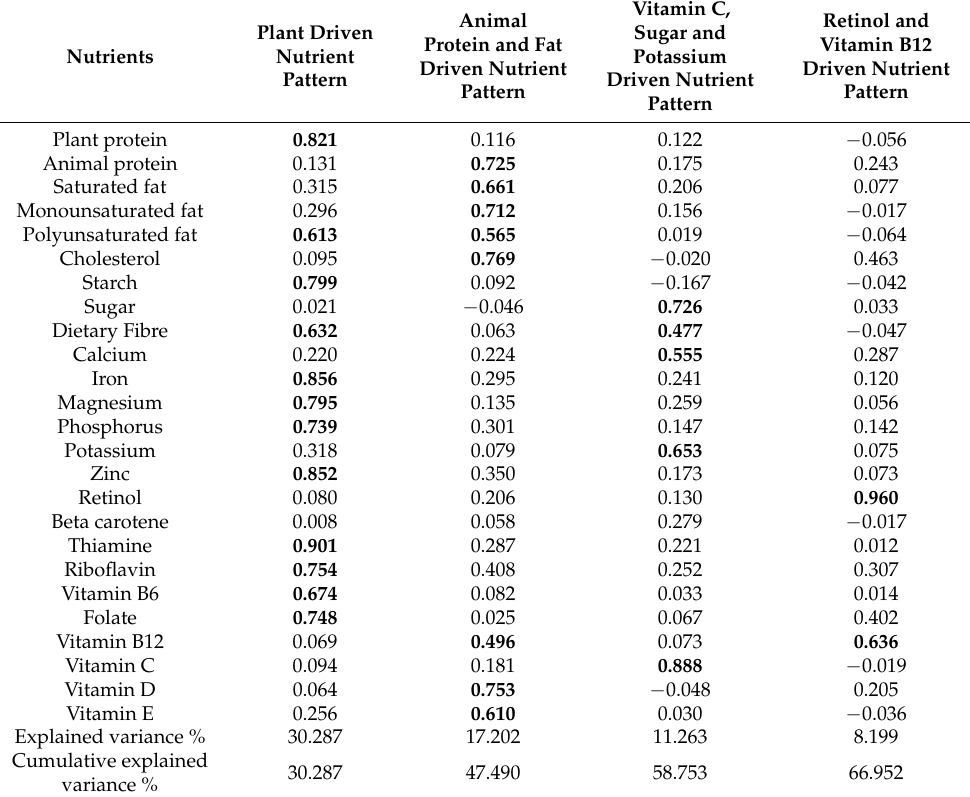
Animal Plant Driven Protein and Fat Nutrient Driven Nutrient Pattern Pattern